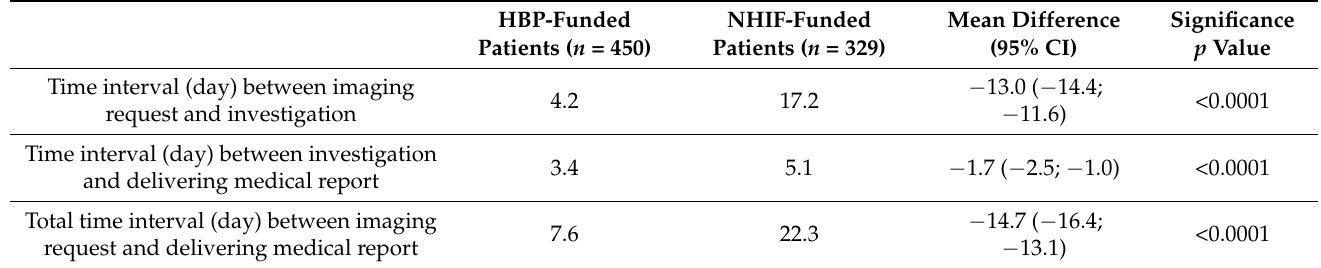
Table 2. Time intervals for steps of CT/MRI imaging process in HBP-funded vs. NHIF-funded patients with definitive or suspected diagnosis of malignancies (entire cohort, but excluding 26.9% of NHIF-funded patients where dates of imaging request and investigation were